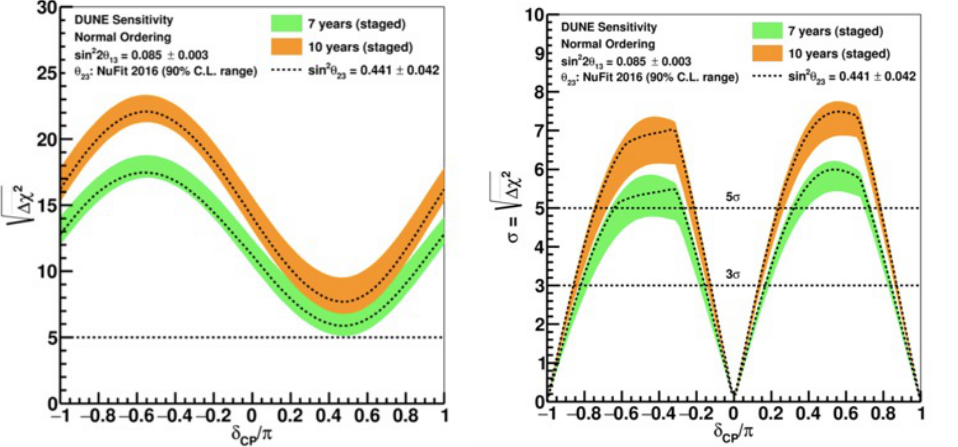
Figure 1: Sensitivity of DUNE to the neutrino mass ordering (left) and the leptonic CP violation phase (right). The staging approached is described in Section 3. The green and orange bands correspond to an exposure of 300 and 556 kton × MW × y respectively. From Ref. [ 2 ]